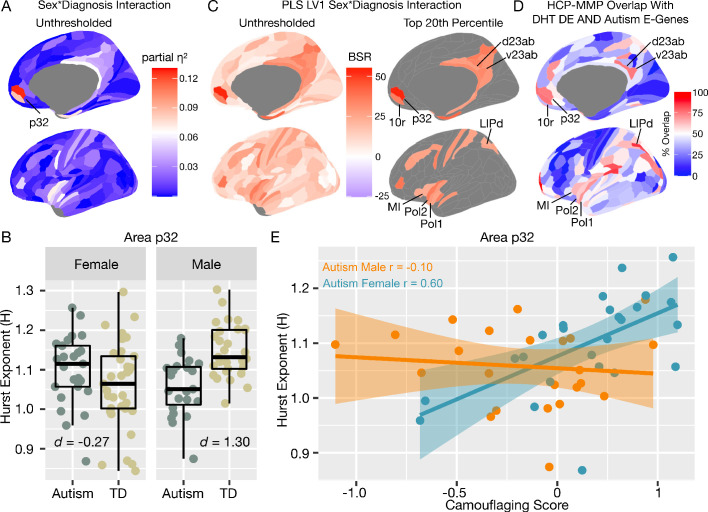
Autism rsfMRI sex-by-diagnosis interaction results.Panel A shows unthresholded and thresholded with FDR q < 0.05 mass-univariate results for the sex-by-diagnosis interaction contrast. Panel B shows H estimates from vMPFC (area p32) across males and females with and without autism. Panel C shows partial least squares (PLS) results unthresholded and thresholded to show the top 20% of brain regions ranked by bootstrap ratio (BSR). Panel D shows the percentage of voxels within each HCP-MMP parcellation region that overlap with the DHT-sensitive AND autism-associated genes affecting excitatory neurons (Autism E-Genes) map shown in Figure 4B. Panel E shows correlation between vMPFC H and behavioral camouflaging score in autistic males (orange) and females (blue).